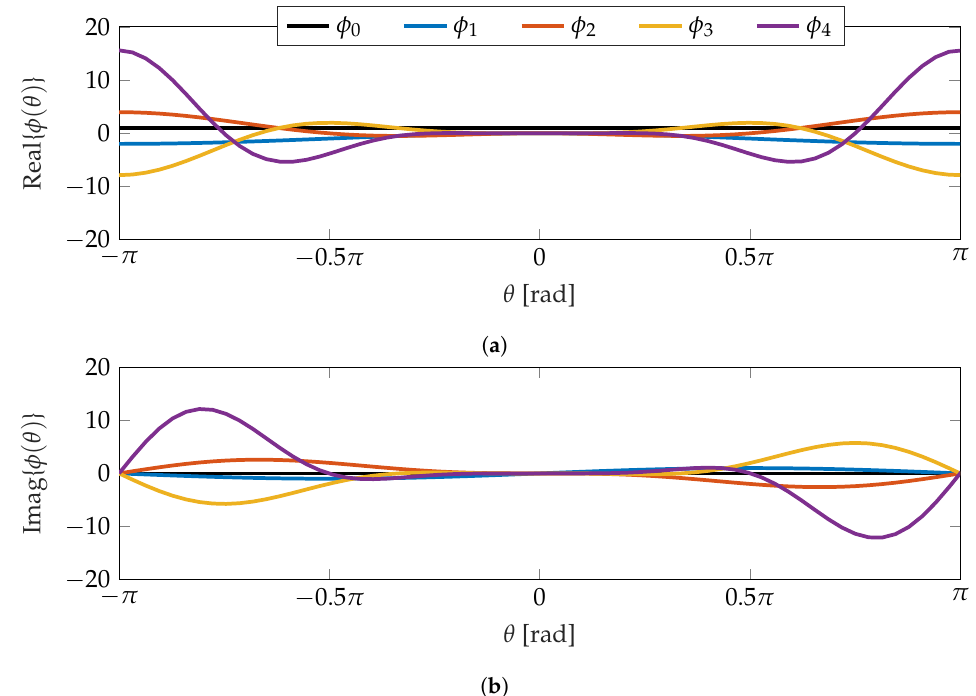
Figure 3. The zeroth through fourth Rogers-Szeg˝o polynomials with an unwrapped standard deviation of 0.1. ( a ) Real Component. ( b ) Imaginary